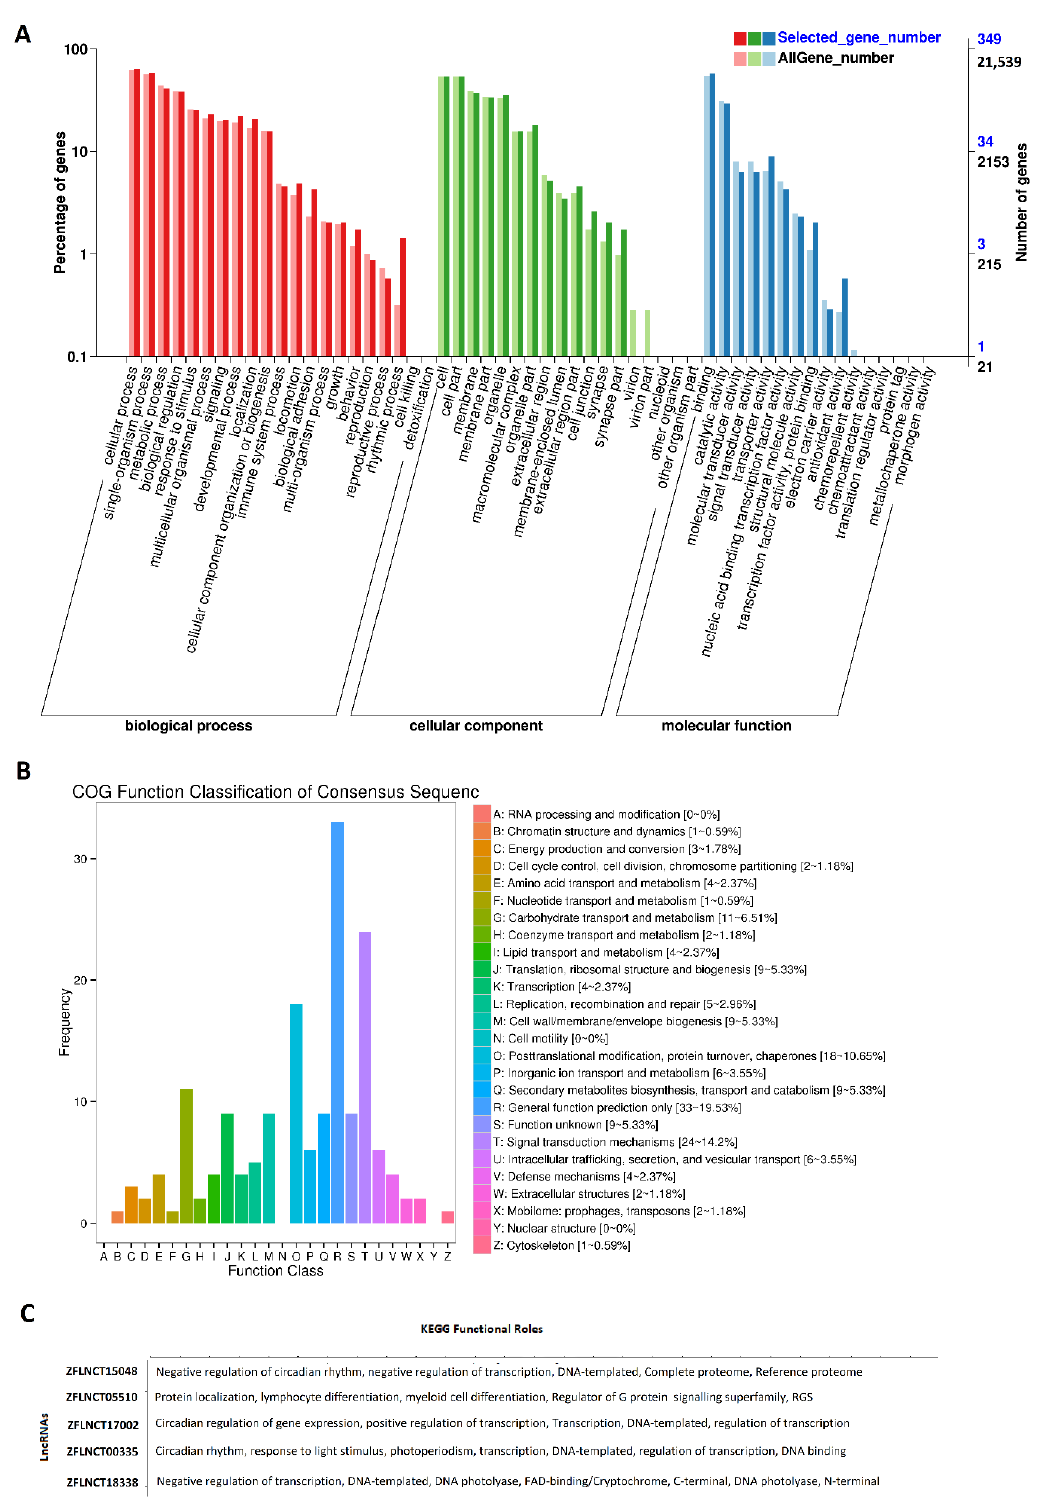
Figure 2. GO, COG, and KEGG analyses of rhythmically expressed pineal gland lncRNAs: GO annotation revealed the percentage of genes involved in different biological processes, cellular components (e.g., cell membrane part, macromolecular complex, and synapse), and molecular functions ( A ), COG functional classification of lncRNAs ( B ), and KEGG functional roles of the representative lncRNAs ( C